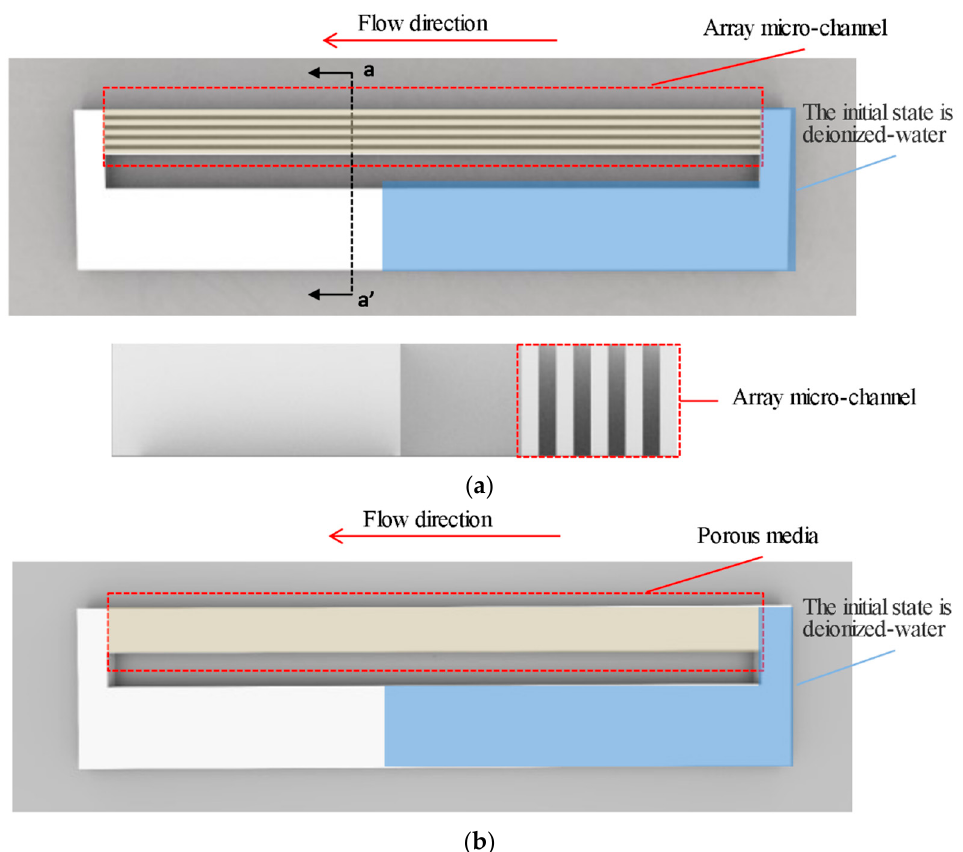
Figure 5. Physical models of two-phase flow: ( a ) The physical model of two-phase flow includes a cavity part and a microchannel part. The blue part is deionized-water and the rest is air at the initial state. The direction of liquid suction is indicated by the arrow; ( b ) The physical model of two-phase flow of porous media is basically the same as that of microchannels with the microchannels partially replaced by porous media.